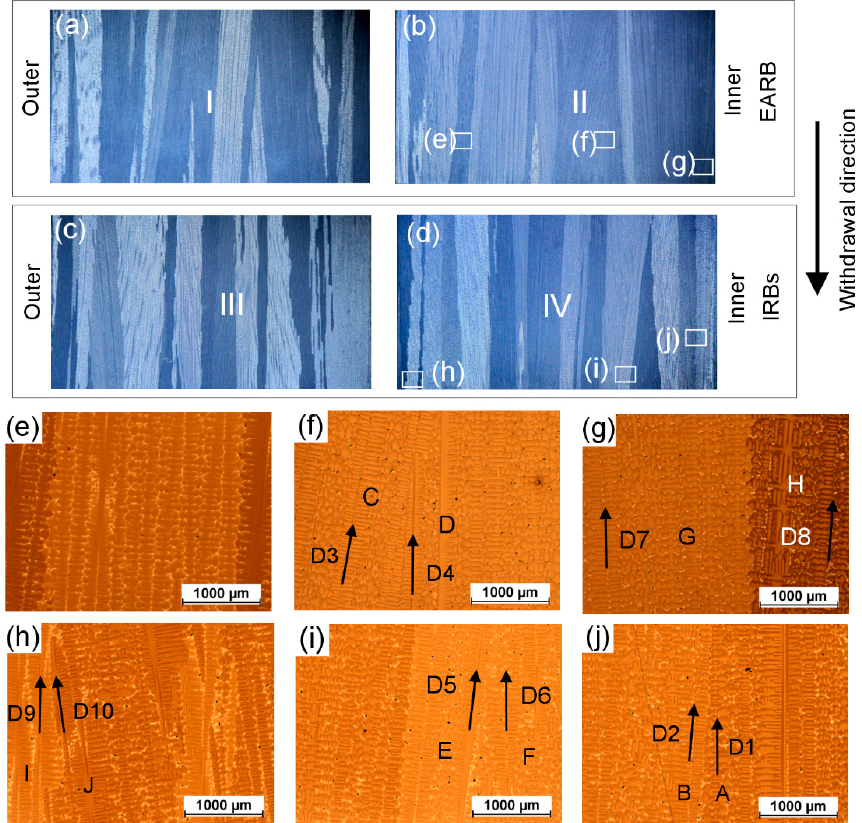
Figure 13. Grains structure at left ( b , d ) and right ( a , c ) side of casting surface at a height ranging from 100 to 120 mm for the process without ( a , b ) and with use of inner radiation baffles (IRBs) ( c , d ). Example of dendritic microstructures at selected areas ( e – j ) of casting surface—the direction of dendrite trunk growth (D1–D10) is schematically marked with arrows in grains.